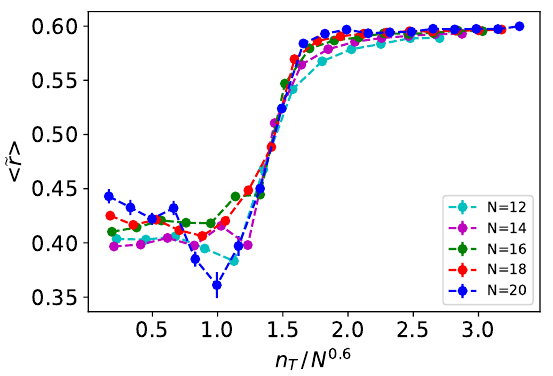
/ N 0.6 for the special case T ≈ 0.39 r (cid:101) Poisson